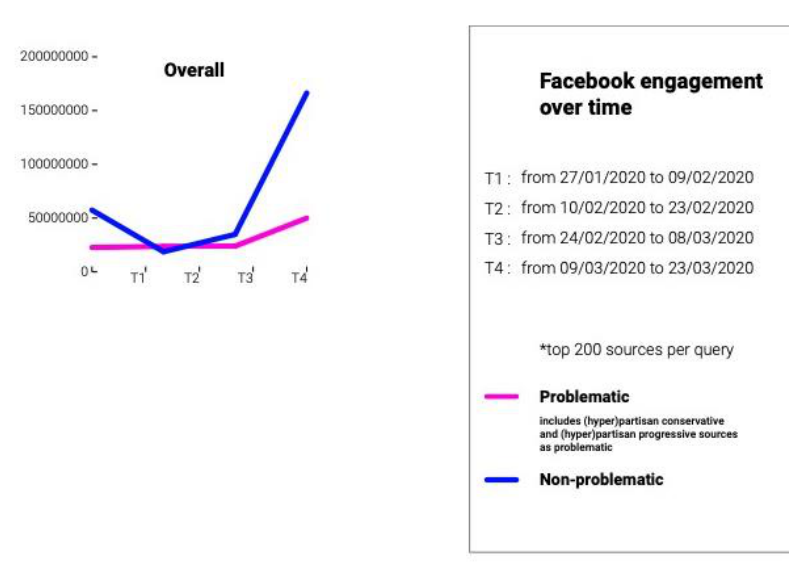
Figure 2. Facebook engagement scores of ‘fake news’ (Silverman’s roomy definition) versus mainstream news for